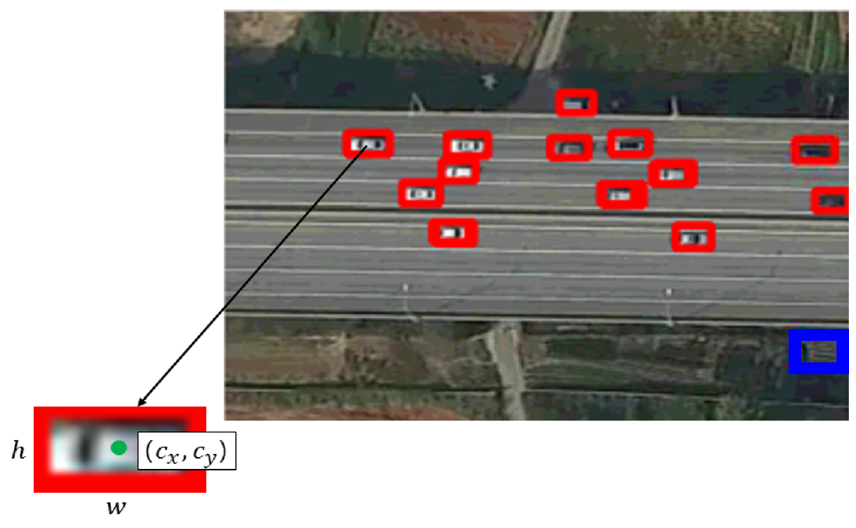
Figure 3. Vehicle detection results using